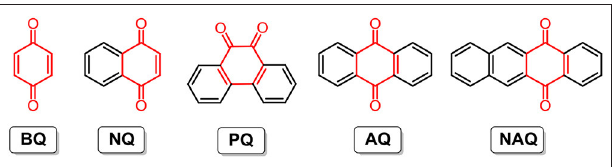
FIGURE 3 | Molecular structures of quinone derivatives in non-aqueous